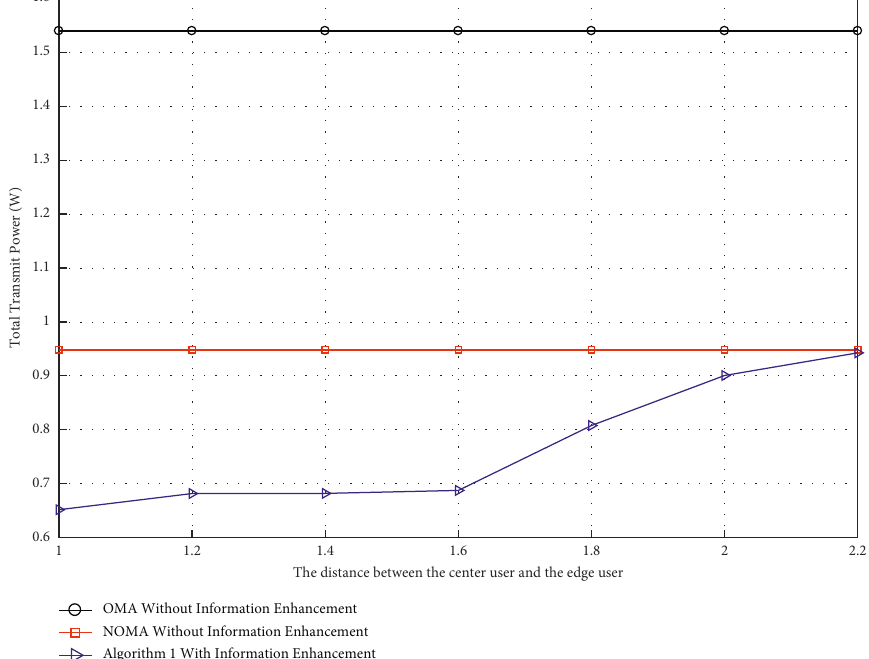
Algorithm 1 OMA Without Information Enhancement Algorithm1 NOMA Without Information Enhancement Algorithm 1 NOMA With Information Enhancement